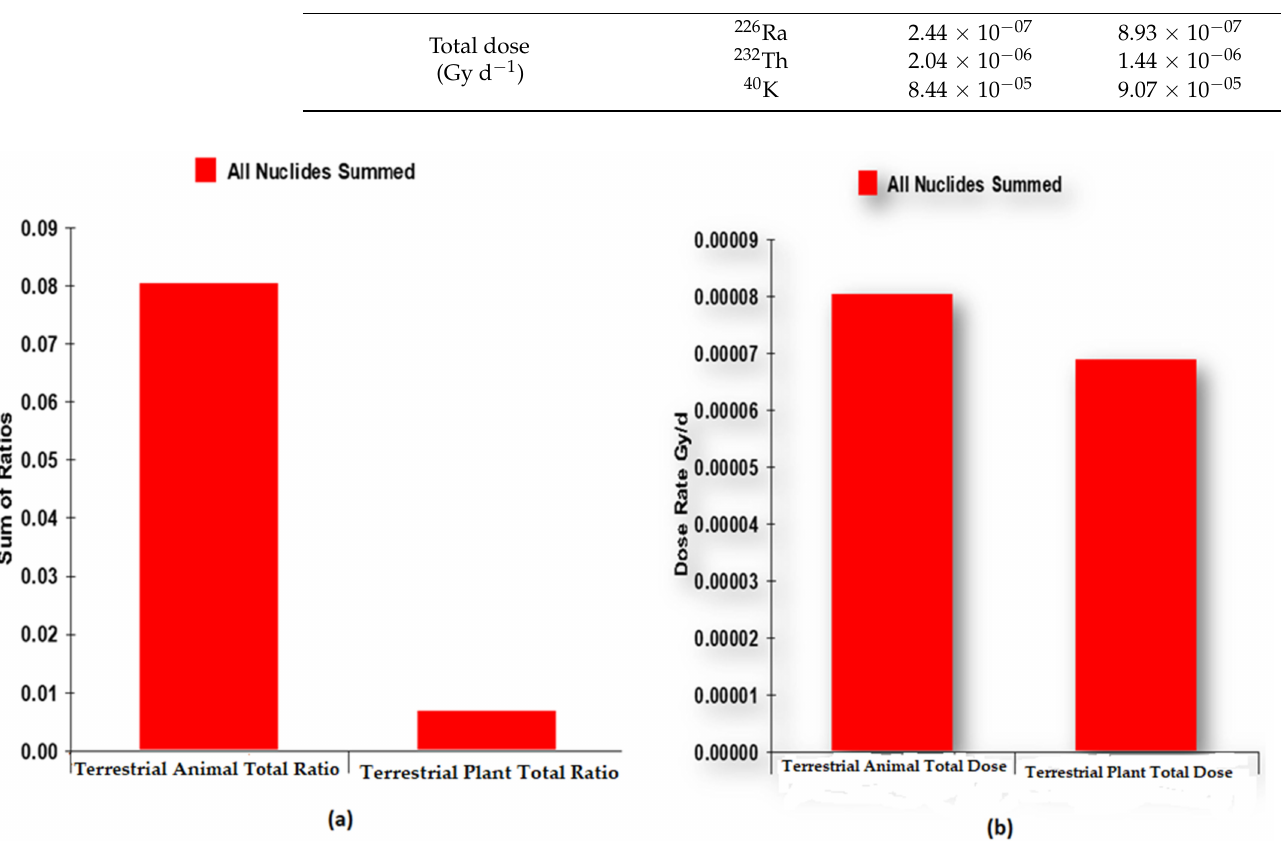
Figure 2. Sum Ratio Factor (SRF) ( a ) and total dose rate ( b